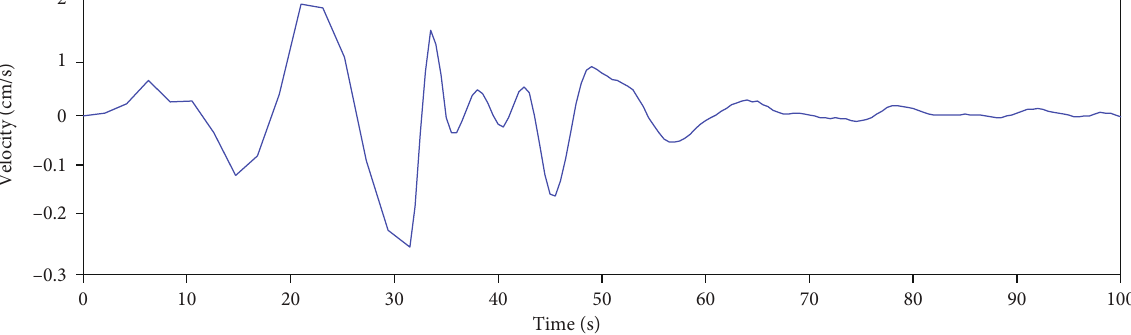
Figure 6: Vibration waveform of single hole blasting.